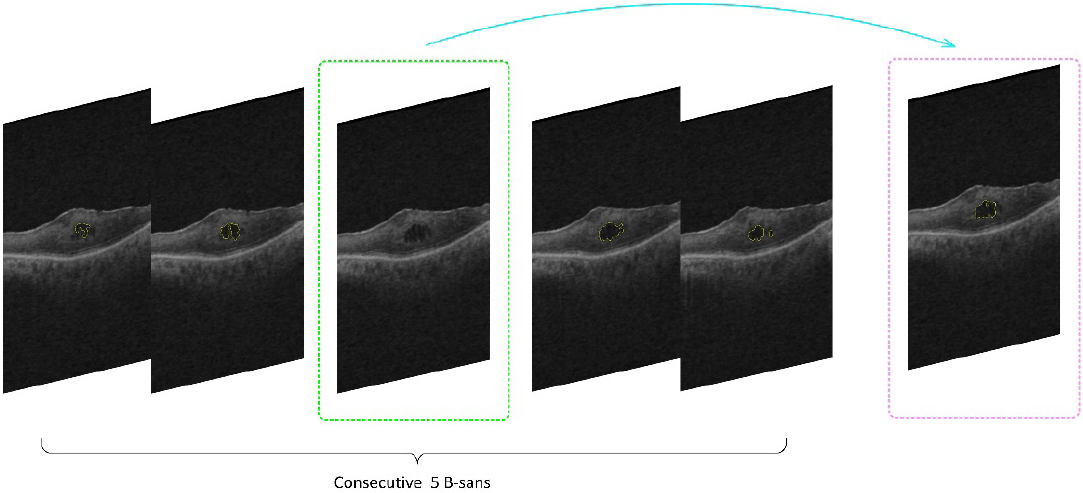
Fig. 7. The third image with green contour is the coarse segmentation. The right one with pink box is the result obtained from searching for undetected °uid areas using spatial